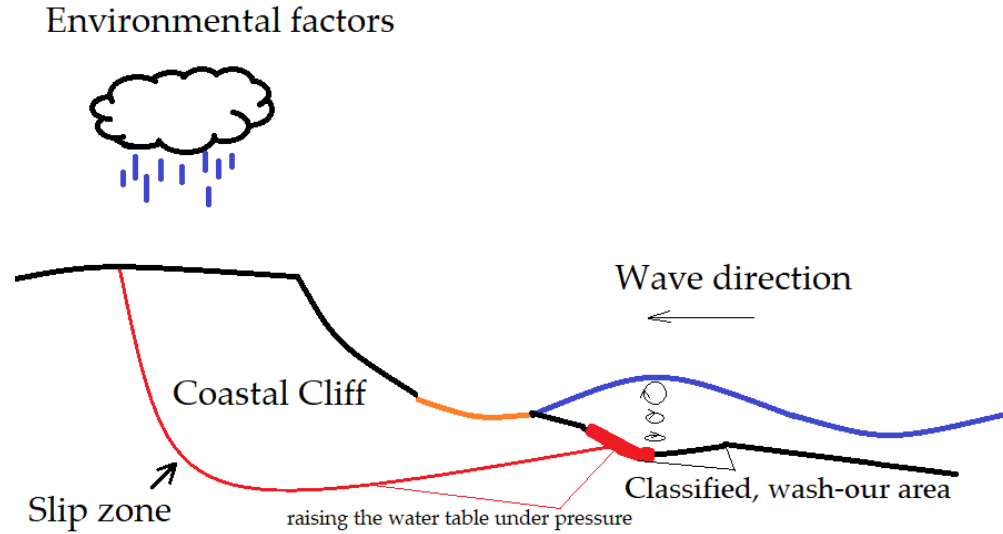
Figure 13. The environmental situation of the studied area. During extreme weather conditions, in the event of soil being washed out (classified as the most negative change in Figure 11c,d), a drainage is created, through which water can enter, thus creating the slip zone.